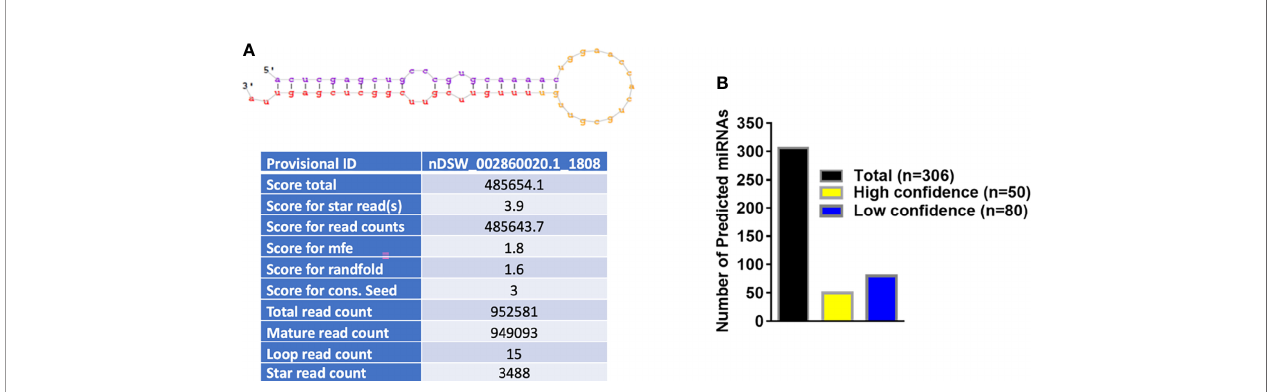
FIGURE 2 | (A) Basic stem-loop structure of a predicted microRNA. miRDeep2 was used to identify potential miRNA precursors based on nucleotide length, star sequence, stem-loop folding, and homology to the Varroa reference genome. Shown are the predicted stem-loop structures (yellow), star (violet), and mature sequences (red). (B) Annotation of predicted Varroa destructor microRNAs. 306 microRNAs were predicted in Varroa samples. 50 were categorized as high- con fi dence and 80 as low-con fi dence miRNAs based on standard